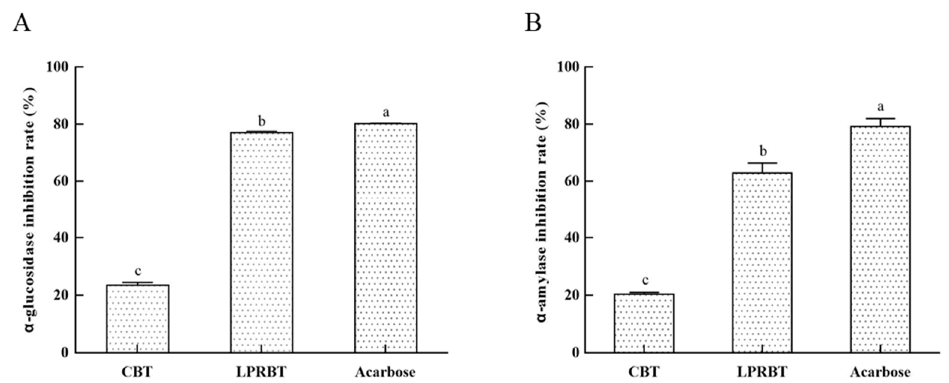
Figure 3. Hypoglycemic function of LPRBT, CBT and Acarbose. ( A ) Hypoglycemic function of LPRBT by inhibition of α -glucosidase; ( B ) Hypoglycemic function of LPRBT by inhibition of α -amylase. CBT: traditional black tea; LPRBT: L. polystachyus black tea. Error bars indicate standard error (SE). Letter designations identify homogeneous groups. Different letters represent significant differences ( p < 0.05). The same letter means there are no statistically significant differences between the means ( p > 0.05).